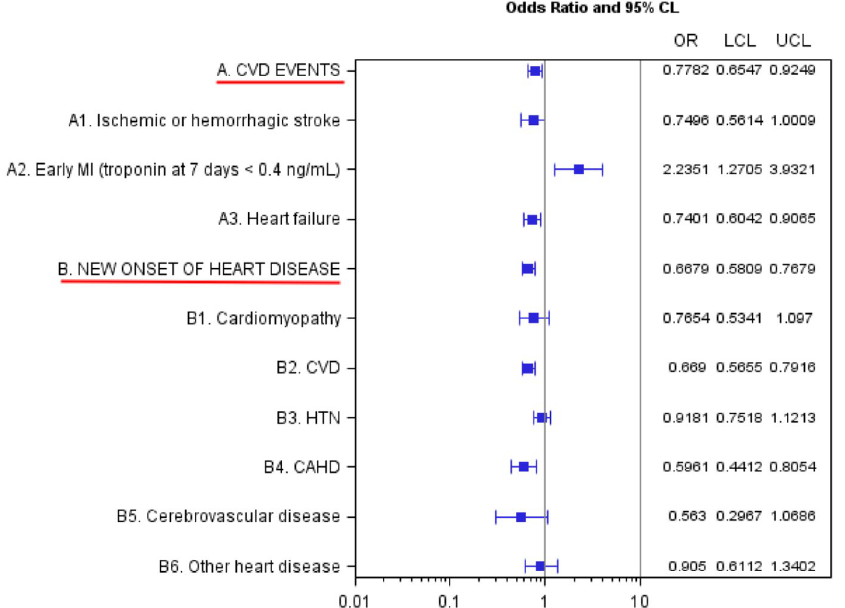
Figure 2. Estimated odds ratios of 60 day cardiovascular outcomes after SARS-CoV-2 exposure. CAHD: Coronary artery Atherosclerosis Disease; CKD: Chronic Kidney disease; CVD: cardiovascular disease; MI: Myocardial Ischemia; HTN: Hypertension; OR = Odds Ratios; CI: Confidence Intervals. a. Adjusted for age at index, race, diabetes, current smoking status, CVD, COPD, CKD, and anticoagulant medication. b. Adjusted for age at index, race, diabetes, current smoking status, COPD, CKD, and anticoagulant medication. c. CVD events included subcategories of events such as Ischemic or hemorrhagic stroke at 60 days, early MI at 7 days, and Heart failure at 60 days. All CVD events are withing 60 days from the index date except early MI which is within 7 days. d. New onset of heart disease included subcategories of heart disease such as Cardiomyopathy, CVD, HTN, CAHD, Cerebrovascular disease, and Other heart disease. e. A 95% CI excluding 1 indicates statistical significance at α: